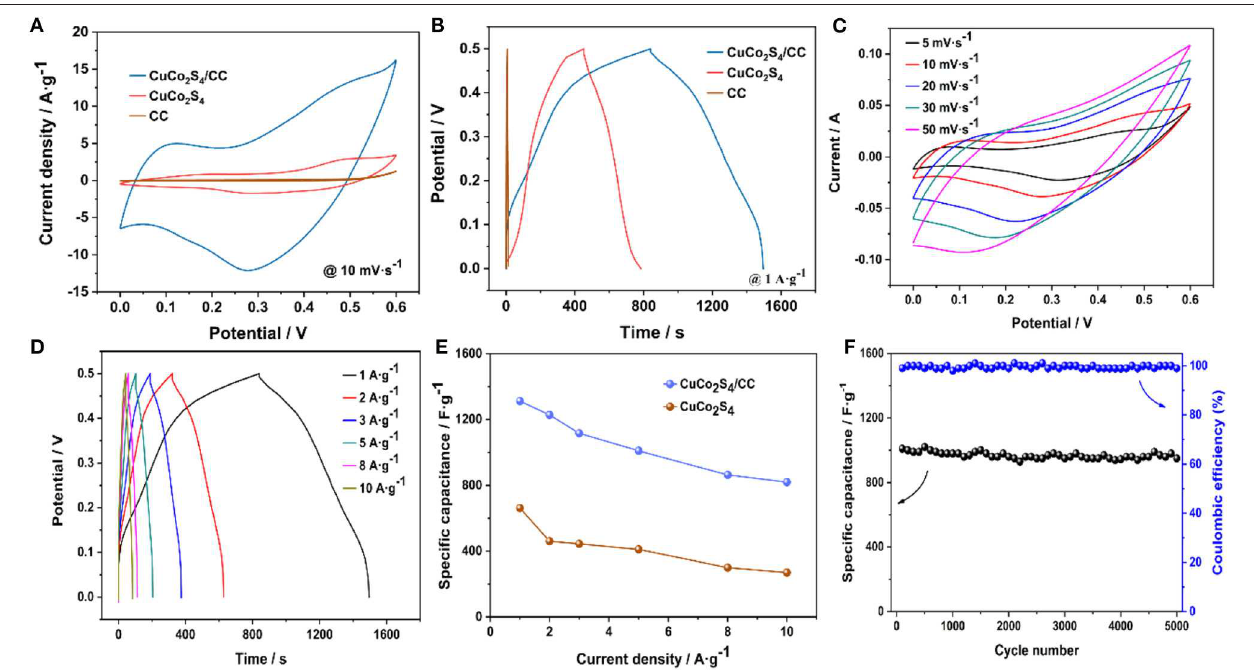
FIGURE 4 | CV curves of CuCo 2 S 4 /CC, CuCo 2 S 4, and blank-CC at 10 mV · s − 1 (A) ; GCD curves of CuCo 2 S 4 /CC, CuCo 2 S 4 , and blank-CC at 1A · g − 1 (B) ; CV curves of CuCo